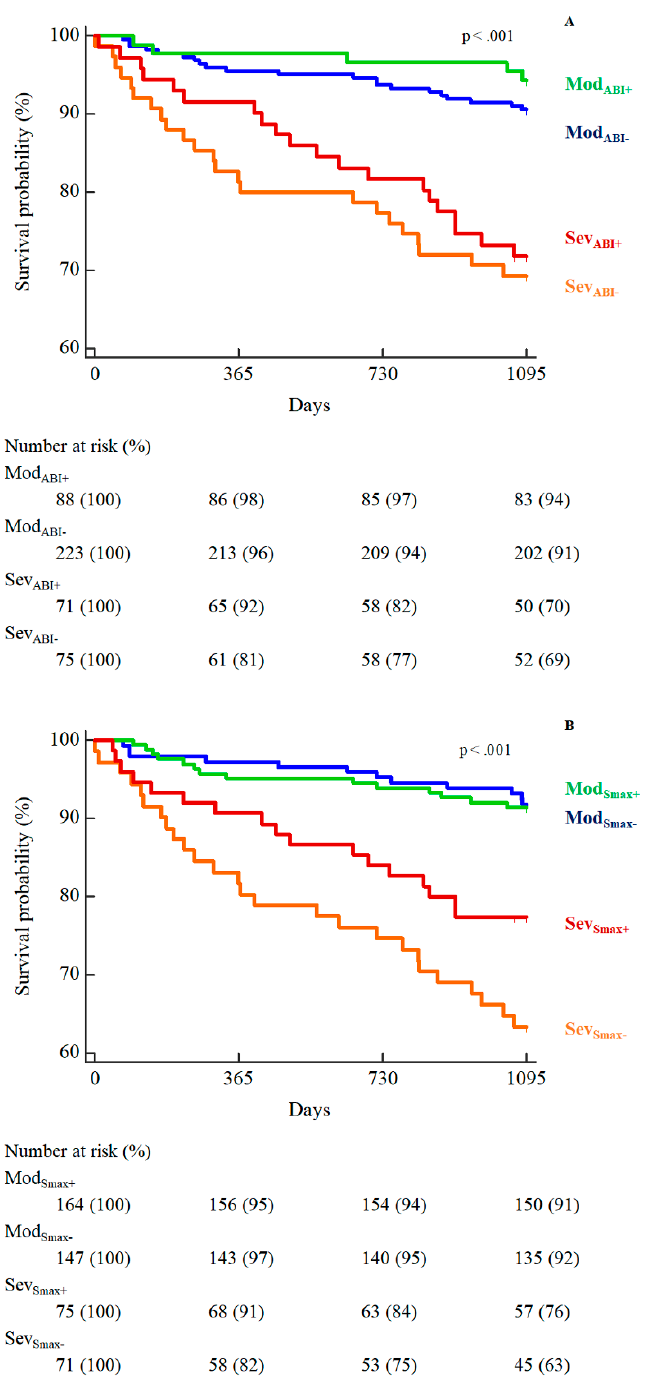
Figure 3. Kaplan-Meier curves of survival in the four patients’ subgroups according to disease severity and ABI ( A ), or maximal speed improvements ( B ).